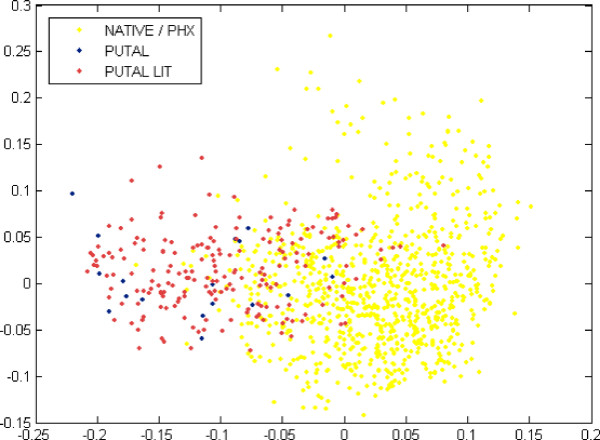
Kernel-based scatter plot visualization of SIGI-HMM predictions for V. cholerae (chromosome II). Blue points (PUTAL) represent pA genes as predicted by SIGI-HMM, red points (PUTAL LIT) indicate predicted pA genes with additional evidence from the current literature as described in the text. Yellow points (NATIVE / PHX) refer to genes which are predicted to be native or highly expressed.